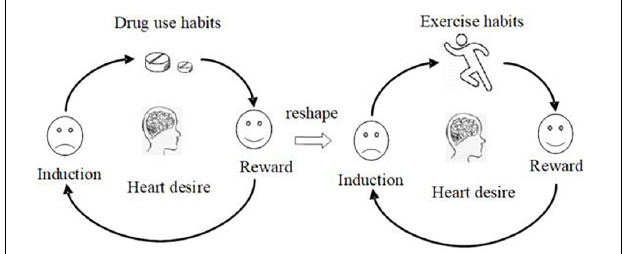
FIGURE 2 | Mechanism diagram of illegal drug use habit replaced by exercise